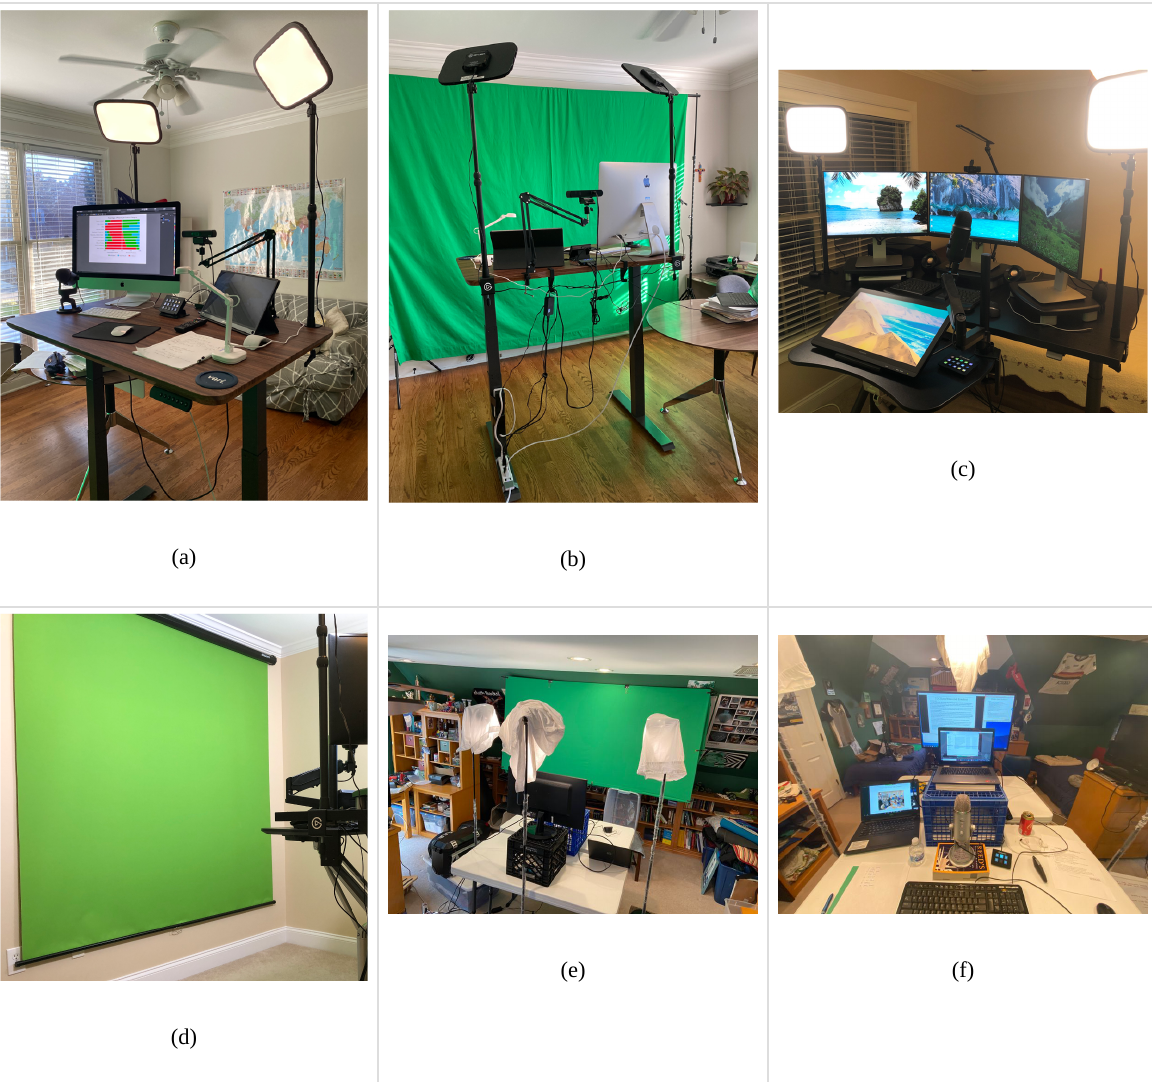
Figure 11. Home studios of Profs. Paolo Letizia (a and b), Justin Jia (c and d), and Chuck Noon (e and f). All three studios use laptops rather than dedicated desktops, and cost less than $1,500 each (not including the laptop). Prof. Noon’s studio was